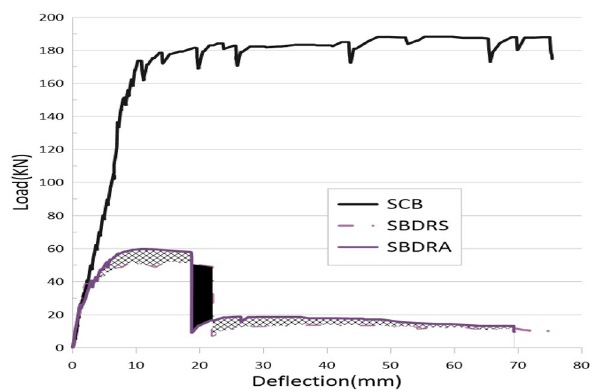
Fig. 7 Load–displacement diagrams of specimens having corroded rebars